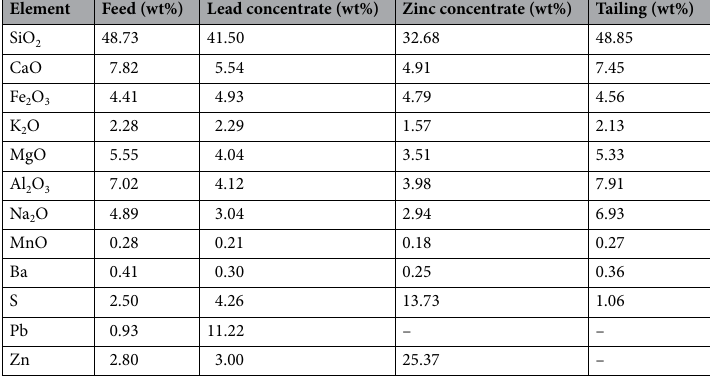
Table 1. Elemental composition of flotation feed, lead and zinc concentrates, and tailing.